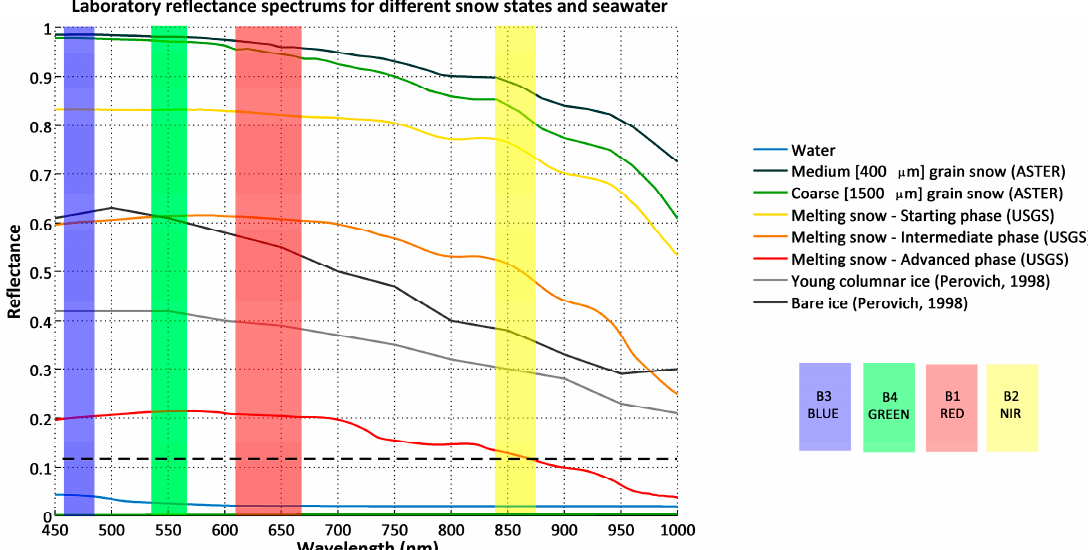
Figure 2. Reference spectrums for different types of ice cover at different states based on USGS [38] and ASTER [39] spectral libraries and from field observations by Perovich in 1998 [40]. These spectrums are solely presented to display the variations in reflectances of the different surfaces encountered by IceMap250.